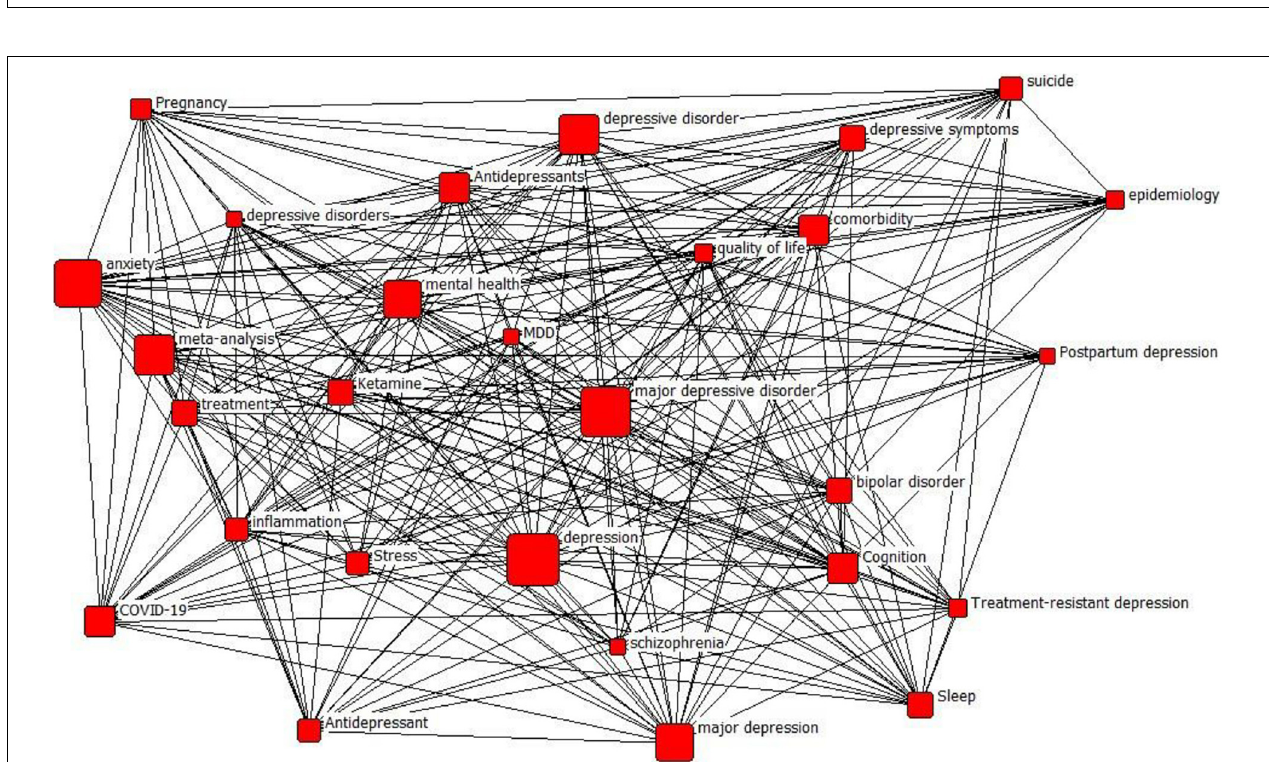
FIGURE 5 | Degree centrality of nodes in the third